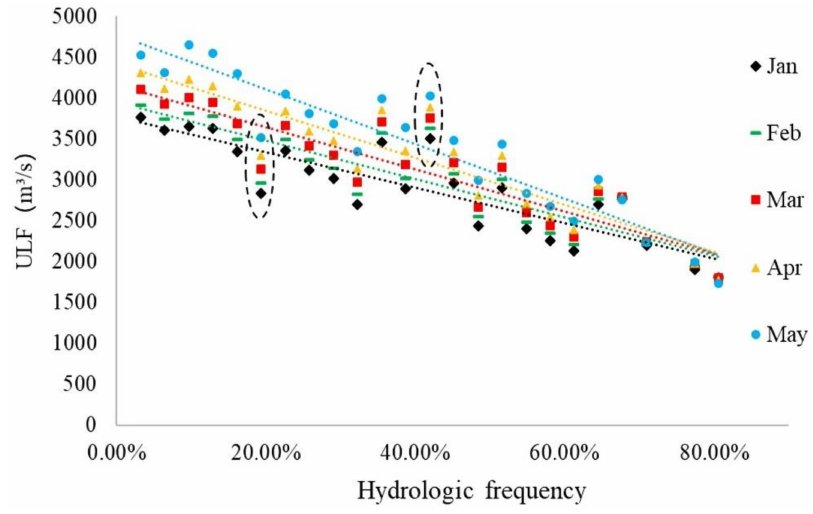
Figure 6. The ULF pattern of all hydrological